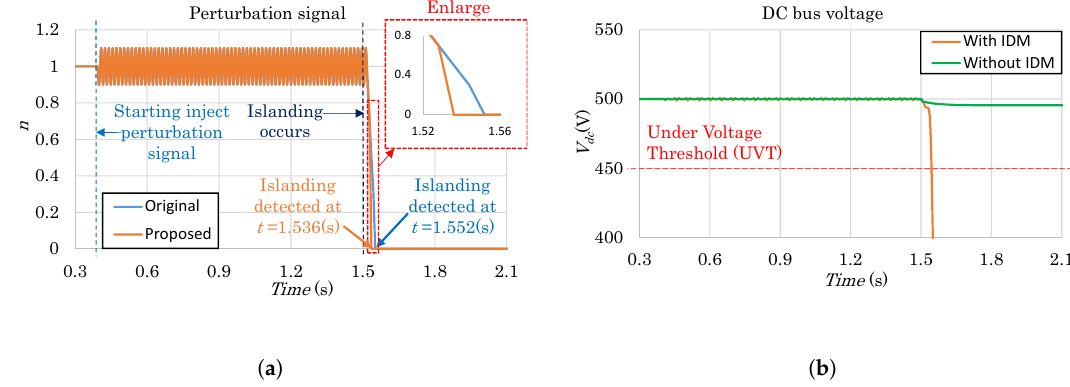
Figure 15. Result in case of multi-PV operation, 100 kW PV, hardest islanding condition (case 3): ( a ) Perturbation signal and ( b ) DC bus voltage (with and without